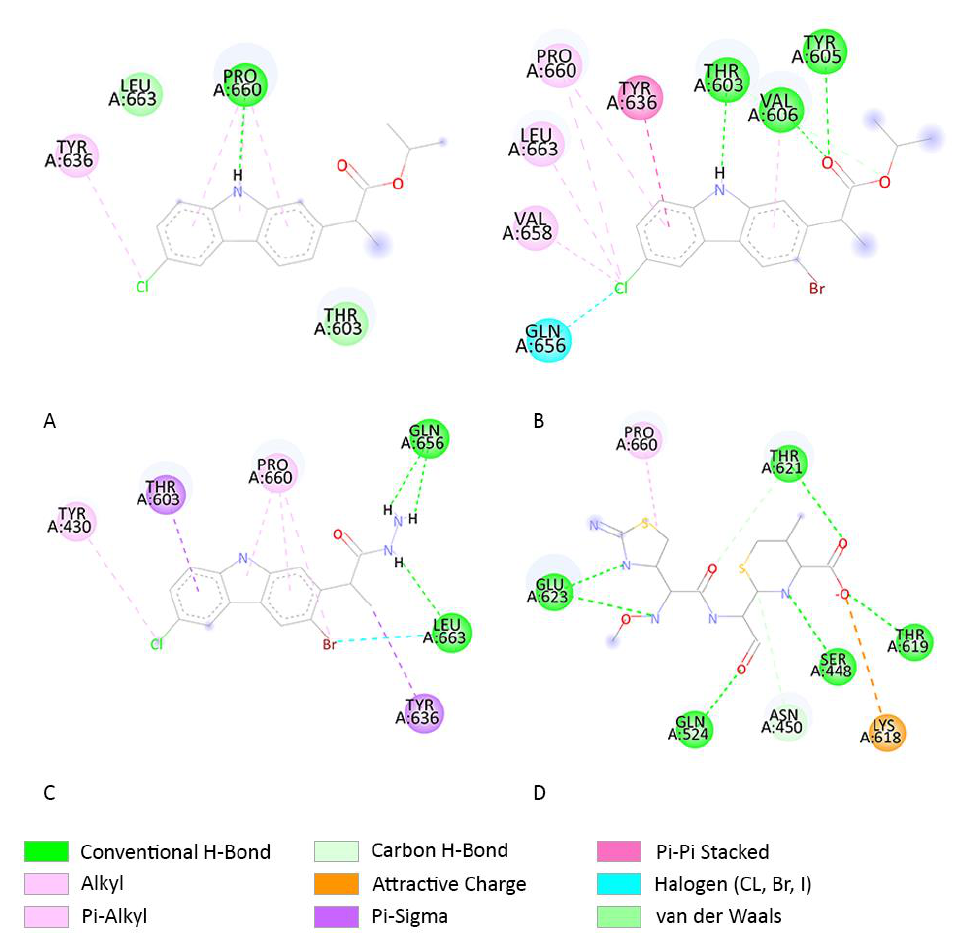
Figure 10. Predicted interactions between compounds 4 ( A ), 7 ( B ), and 10 ( C ) and the PBP3 receptor, and cefotaxime ( D ) in its experimentally determined site. Images were obtained using Discovery Studio Visualizer [33].